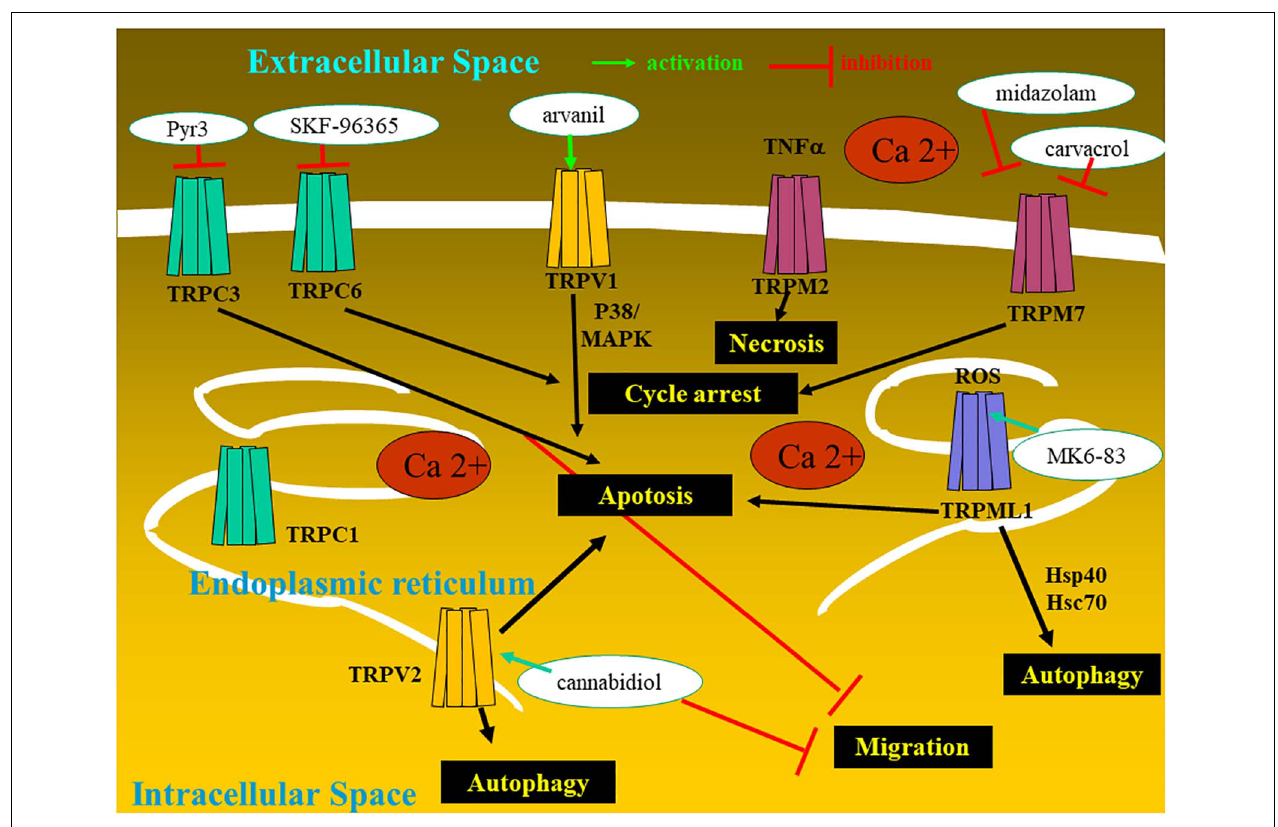
FIGURE 1 | Glioma cell with the expression of transient receptor potential (TRP) ion channels and the therapeutic